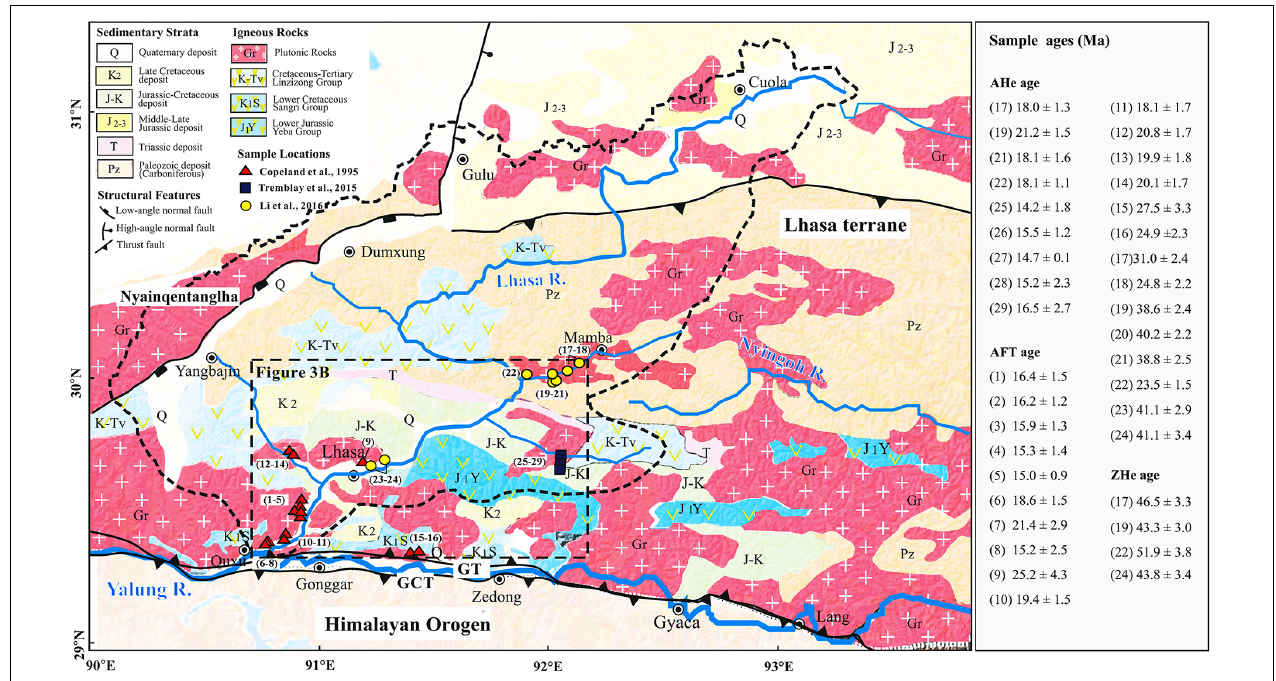
FIGURE 2 | Simplified geologic map and locations of the collected thermochronological data of the Lhasa River drainage in the southern Tibet Plateau [modified from Zhang et al. (2012)]. The black box shows the extent of Figure 3B . GT, Gangdese Thrust; GCT, Great Counter Thrust. The number in the black box represents the position of the compiled